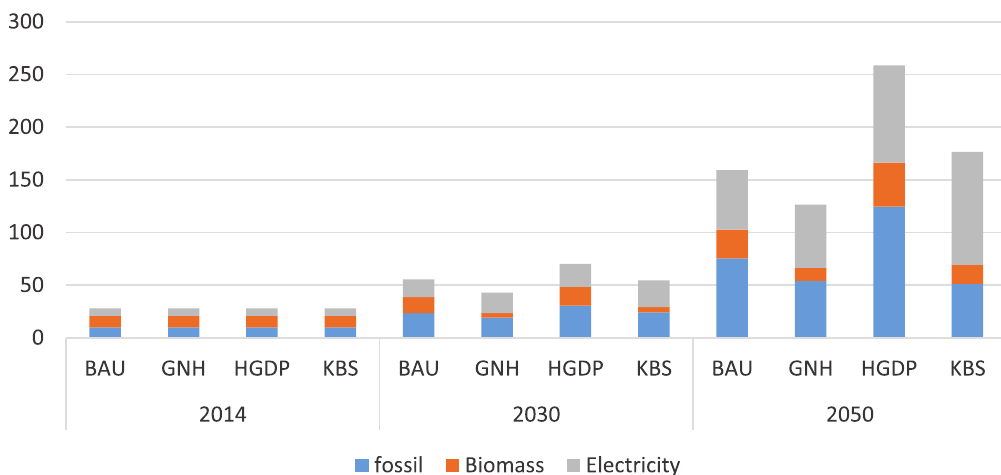
Figure 2. Energy consumption by major fuel group under four different scenarios. Note: BAU (Business as Usual); GNH (Scenario following GNH principle); HGDP (high economic outlook); KBS (knowledge-based